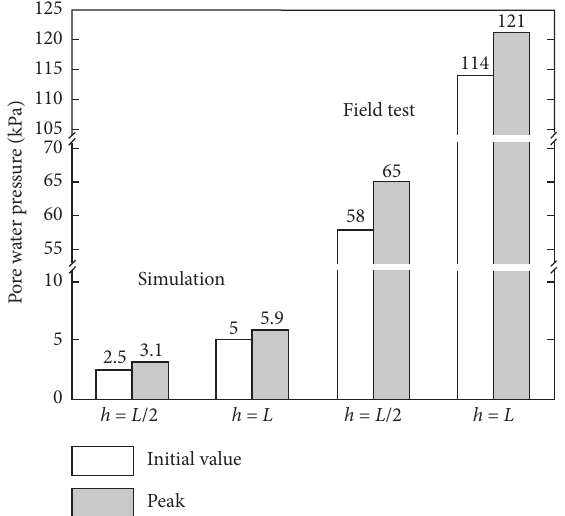
Figure 14: Comparison between the peak and the initial value of pore water pressure.